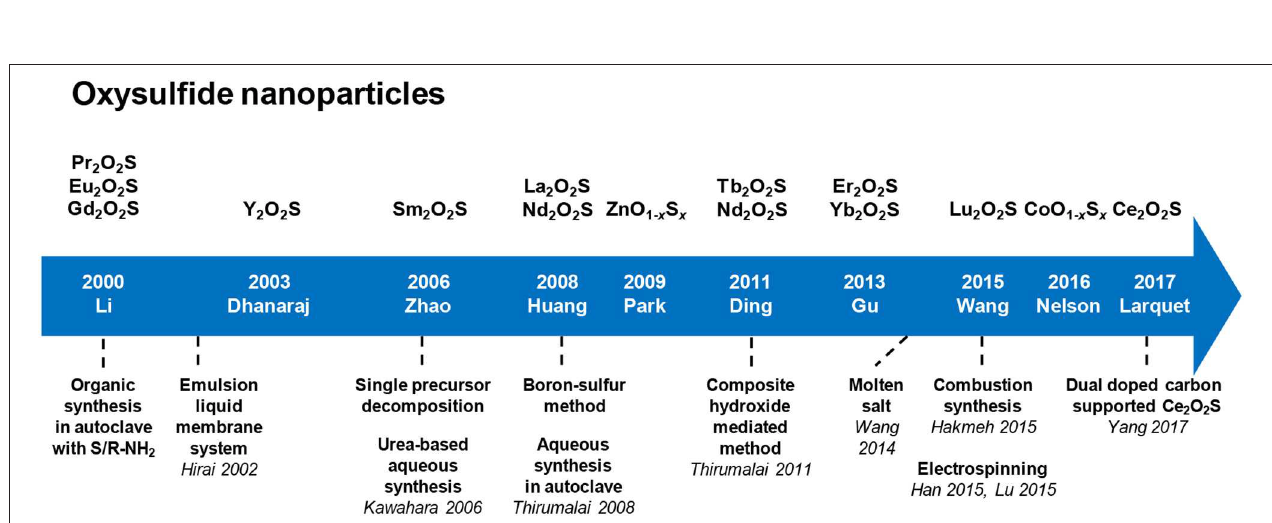
FIGURE 6 | Key dates, authors, and techniques of the oxysulfide nanoparticles research.